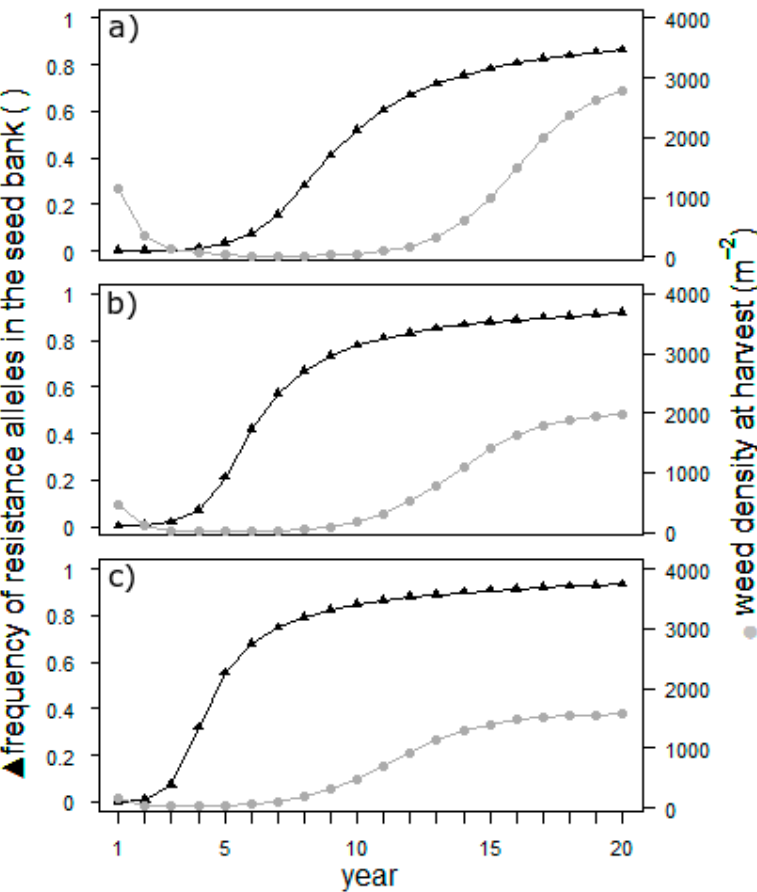
Figure 3. Results of an Echinochloa crus-galli herbicide resistance model in maize, simulated over 20 years. Frequency of resistance alleles in the seed bank after harvest (means of 15 simulation runs) and weed density at harvest (means of 15 simulation runs) depend on the degree of suppression of a second cohort of E. crus-galli after the first cohort is treated by an herbicide. ( a ) 0% suppression; ( b ) 30% suppression; and ( c ) 100% suppression. Figure extracted from [15].